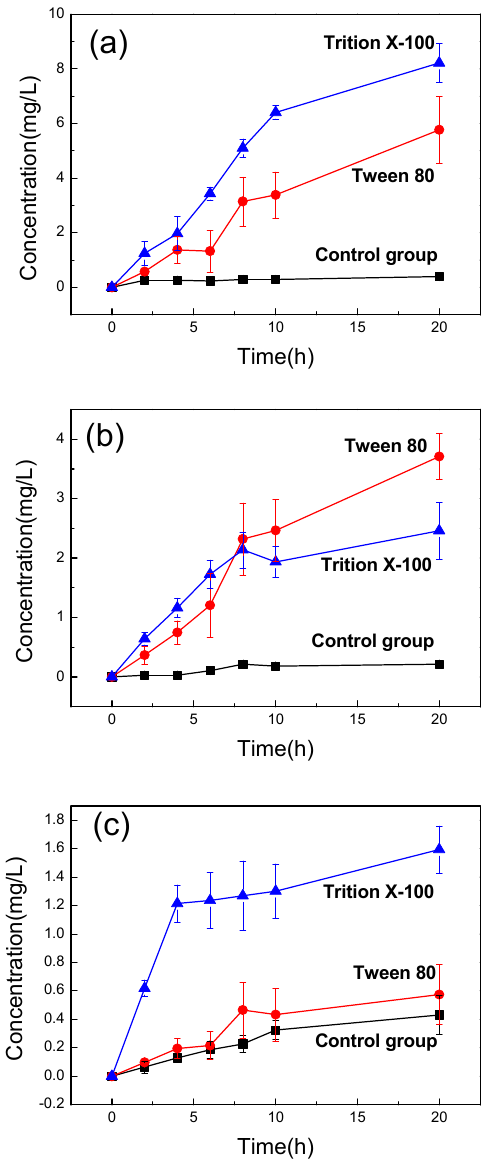
Figure 5. Change of extracellular concentration of different substances with time: ( a ) Methylene blue, ( b ) Acid orange II, and ( c ) Pyrrole structure nano-pigment. ( b ) Acid orange II, and ( c ) Pyrrole structure